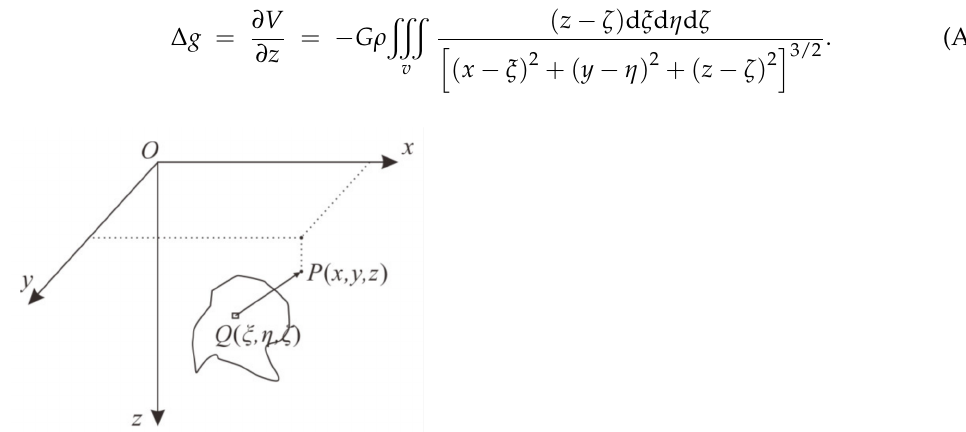
Figure A2. Gravitational potential and field of the geological